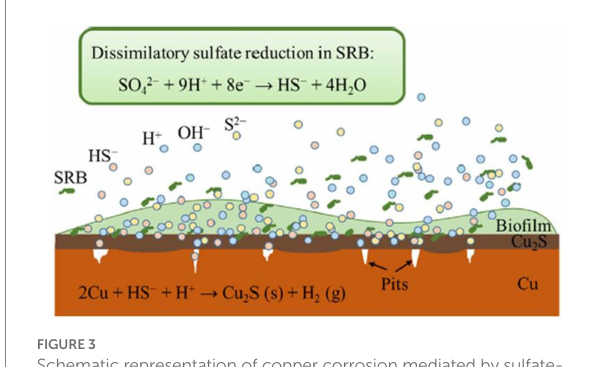
FIGURE 3 Schematic representation of copper corrosion mediated by sulfate- reducing bacteria (SRB) activity. Obtained from Dou et al.